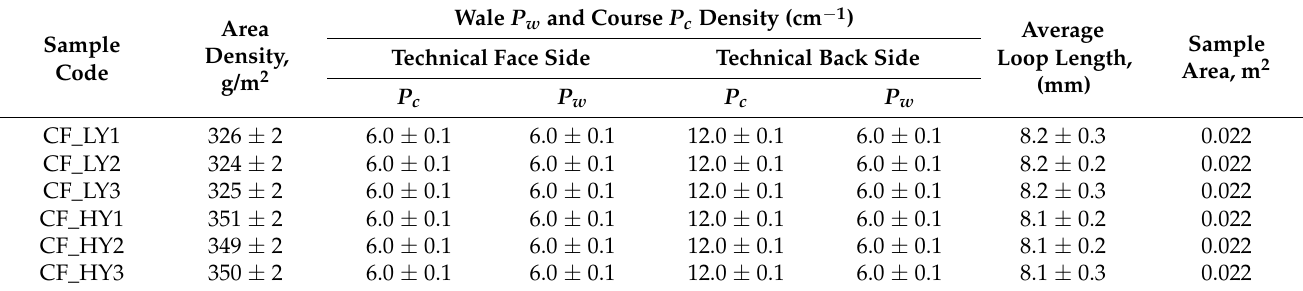
Table 1. Essential parameters of designed composite fabrics.